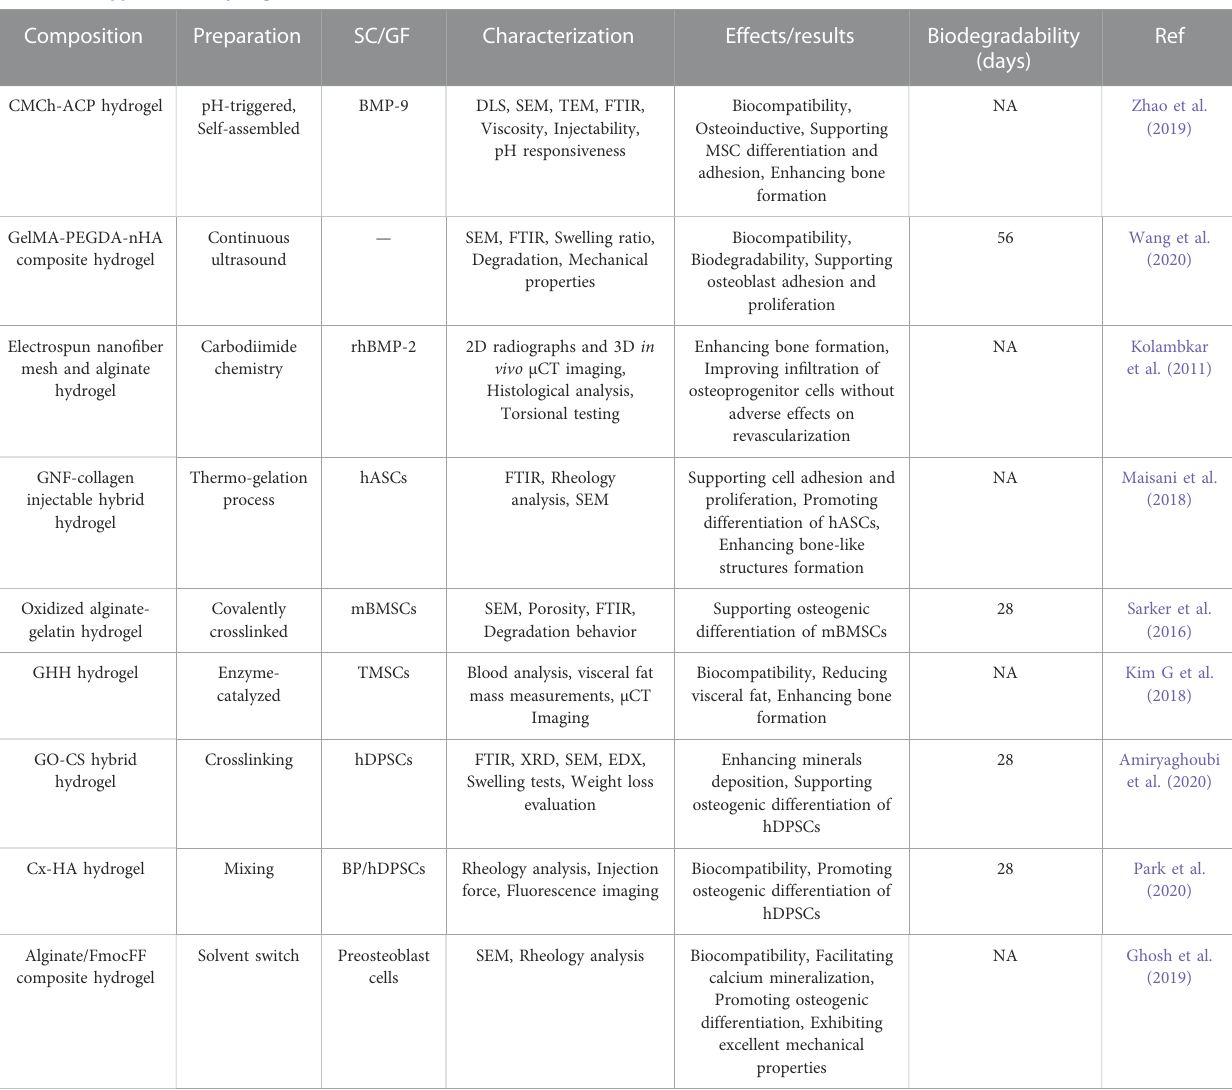
TABLE 2 The application of hydrogels in